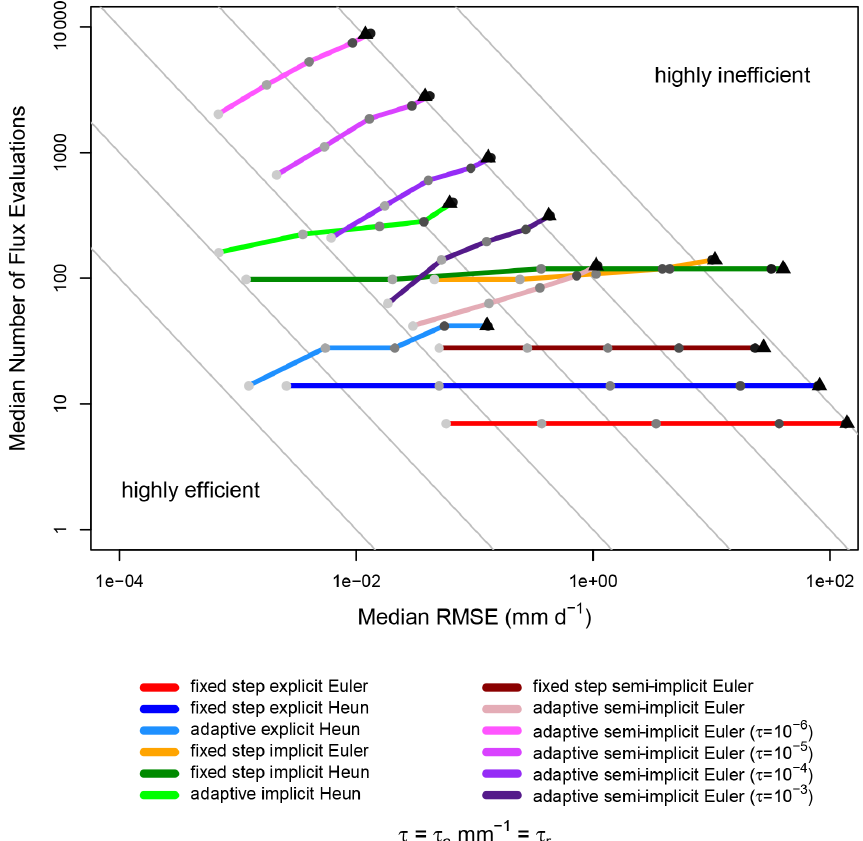
Figure 8. Relationship between computational efficiency and the numerical error, where methods are more efficient if they have a low RMSE and a low number of flux evaluations. All medians are calculated across all five model structures, 20 parameter sets, and three spin-up precipitation intensities. All six precipitation intensities for 5d events are shown, where the light gray dot represents the lowest intensity event, darker gray dots represent increasingly intense precipitation events, and the black triangle represents the highest intensity event. Unless otherwise stated, adaptive methods use the FUSE default tolerances. Purple lines depict adaptive semi-implicit Euler methods with error tolerances below the FUSE default, where the brightest purple method has the smallest error tolerance. Gray lines are visual aids of the n form y = 10 , where n is an integer, and x and y , respectively, represent RMSE and number of flux evaluations (gray lines do not represent x real data and are used only for visualization purposes). Moving between adjacent gray lines represents an order of magnitude change in